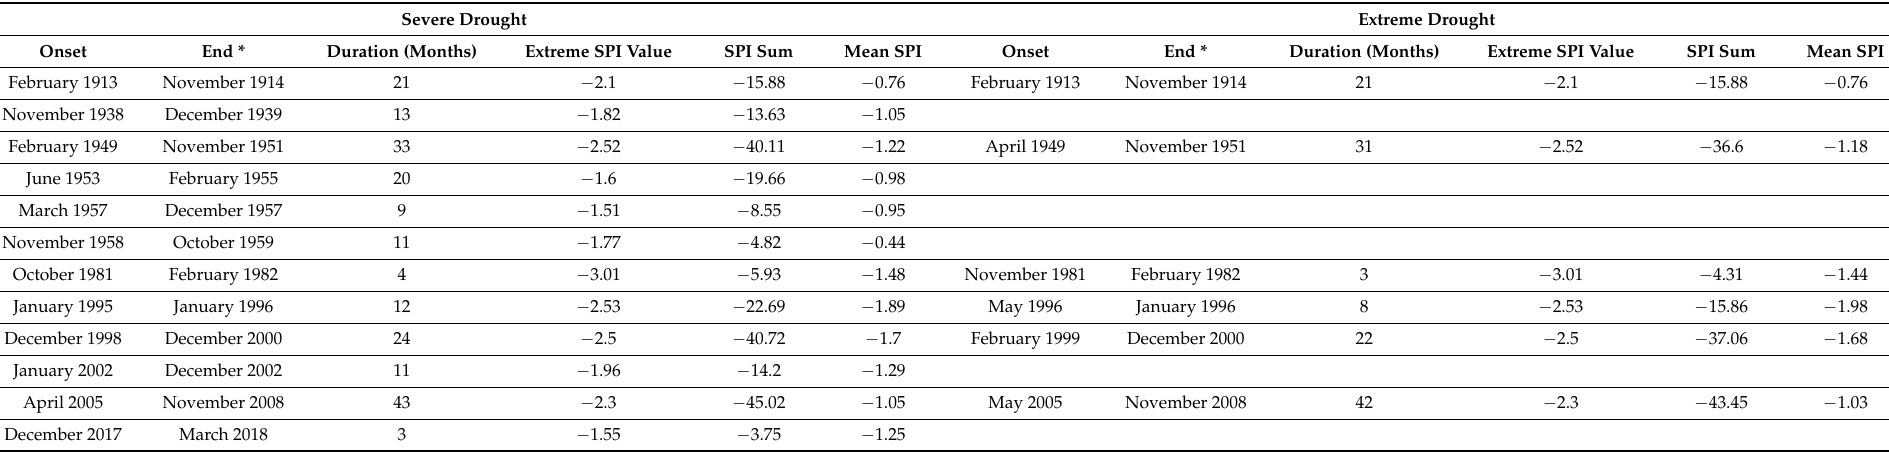
Table 3. Main characteristics of the severe (SPI < − 1.5) and extreme (SPI < − 2) droughts identified in the studied basin for the period.